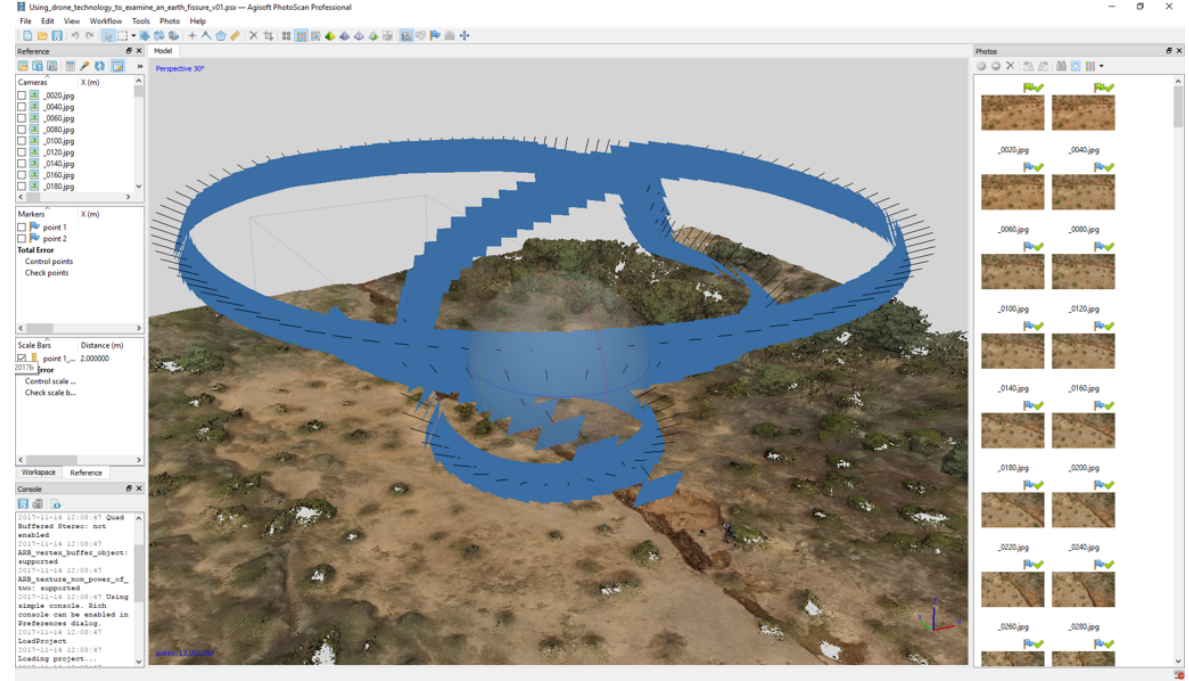
Figure 3. Snapshot of the Agisoft Photoscan software after processing the data.